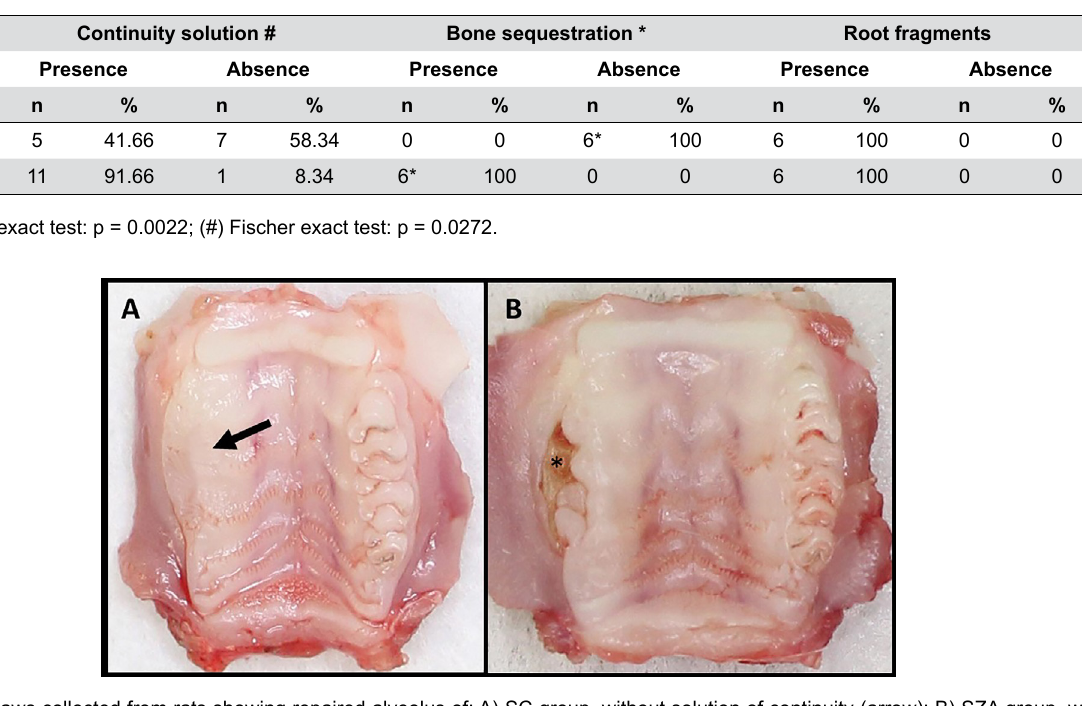
Figure 4- Jaws collected from rats showing repaired alveolus of: A) SC group, without solution of continuity (arrow); B) SZA group, with solution of continuity (*) of oral mucosa, with bone exposure area in the region of molar